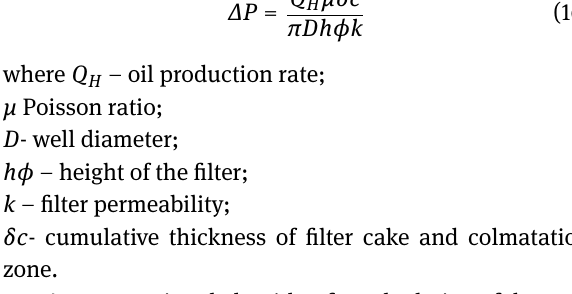
A computational algorithm for calculation of the